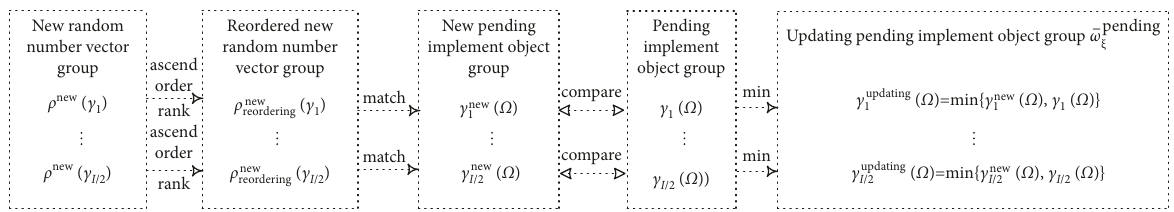
Figure 7: Updating pending implement object